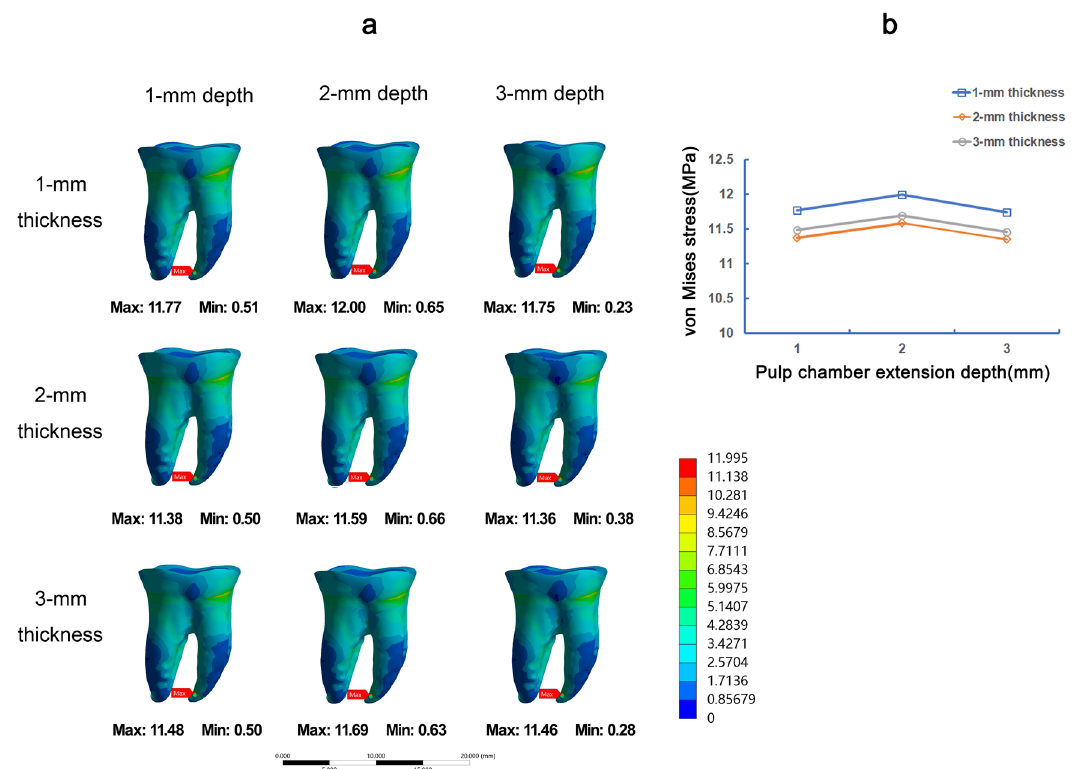
Fig. 4 The von Mises stress (MPa) distribution on teeth tissue in 9 FEA models under vertical load. Stress distribution plots of teeth tissue by endocrown restorations with 1-mm, 2-mm, or 3-mm pulp chamber extension depth in combination with 1-mm, 2-mm, or 3-mm occlusal